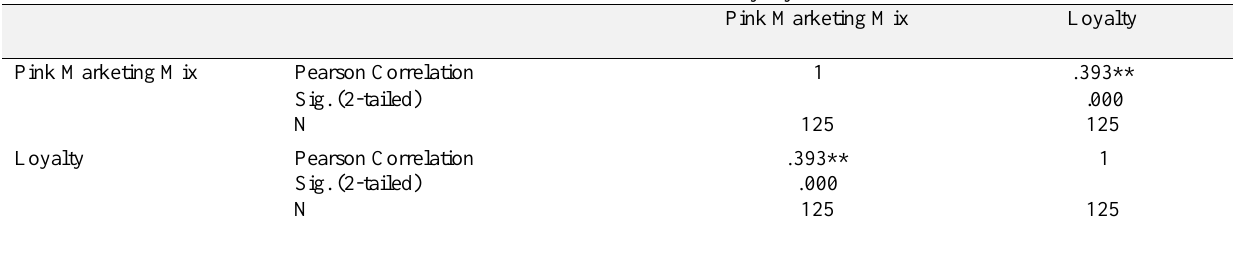
Correlation between Place and